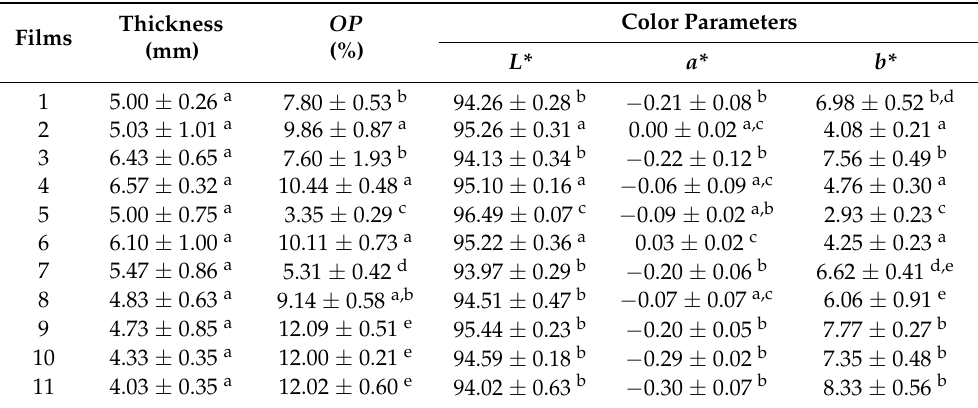
Table 4. Thickness, color parameters ( L* , a* , and b* ), and opacity ( OP ) of alginate films incorporating amaranth phenolic